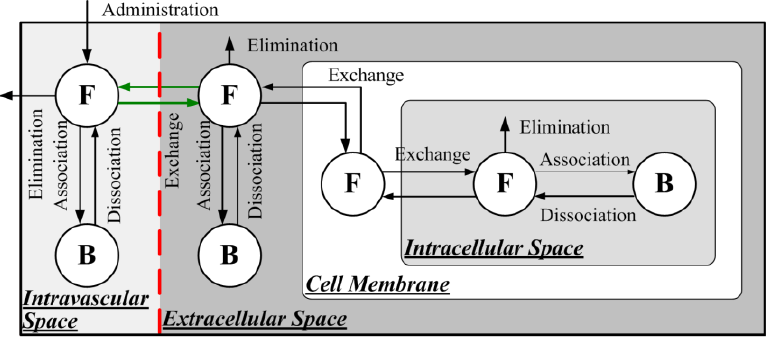
Figure 1. Transport processes involved in direct drug delivery in combination with focused- ultrasound-and-microbubble (FUS-MB)-induced blood–brain barrier disruption (BBBD). Red dashed line indicates the disrupted BBB, and the enhanced transvascular transport processes are highlighted in green.